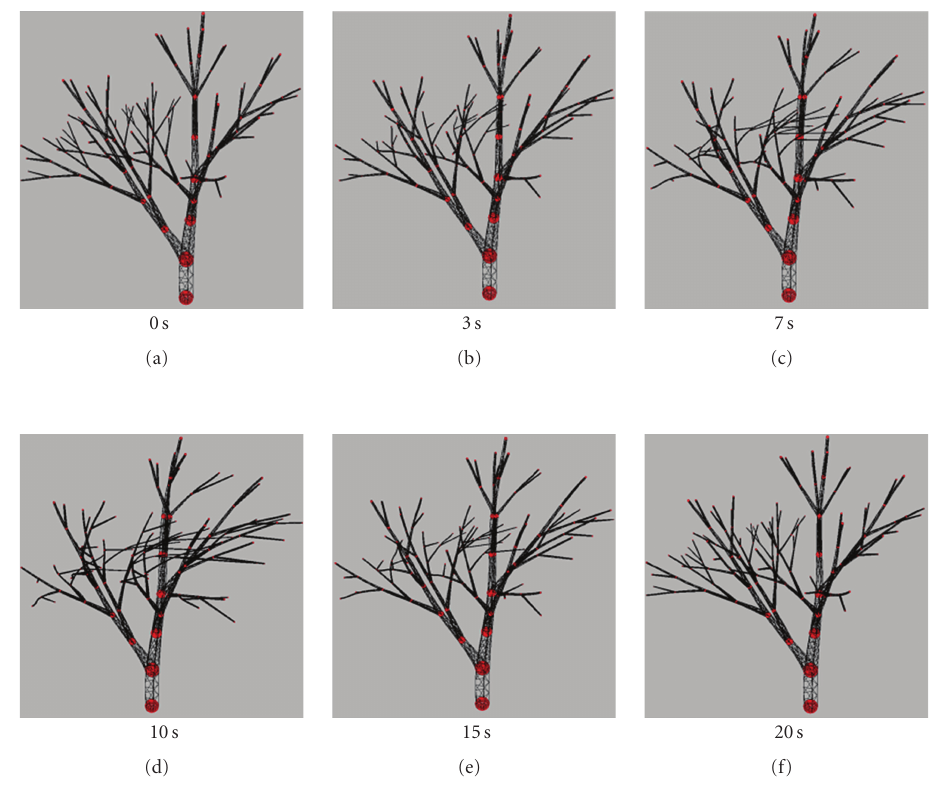
Figure 9: Six states extracted from the 20 seconds animation of a tree.